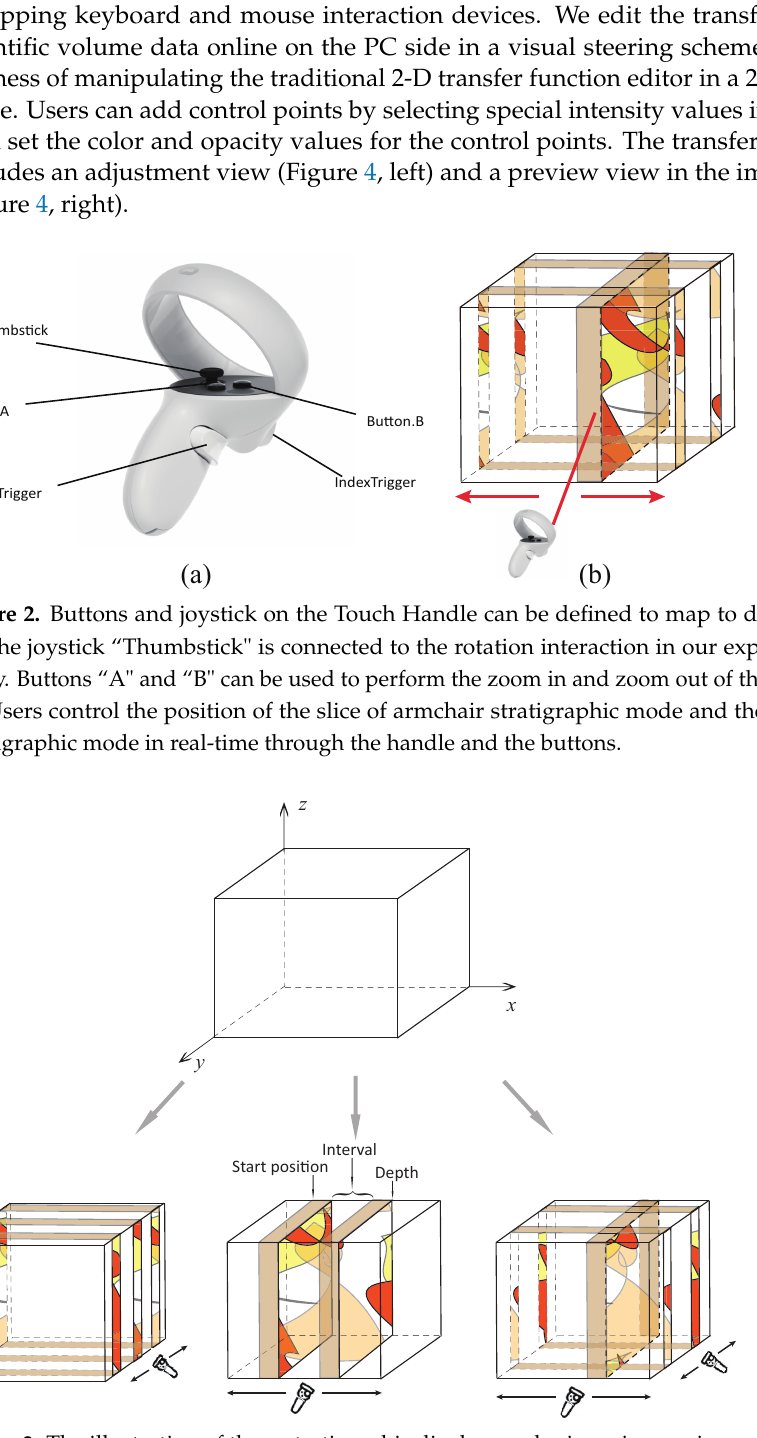
Figure 3. The illustration of three stratigraphic display modes in an immersive environment. which includes the original volume ( top ), the armchair stratigraphic display mode ( bottom left ), the palisade stratigraphic display mode ( bottom middle ), and the cross-shaped stratigraphic display mode ( bottom right ). We refer to these stratigraphic display modes from a previous article